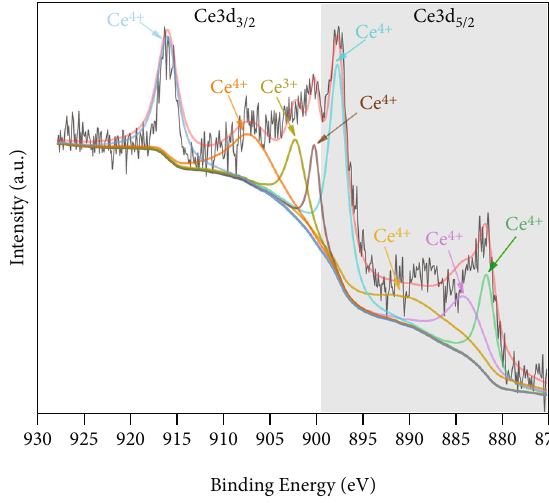
Ce /Al catalyst. 0.4 0.05